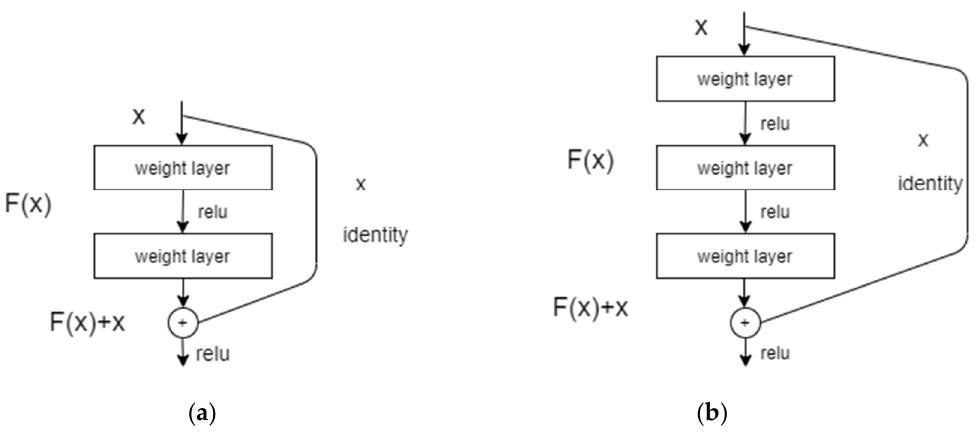
Figure 3. Two-level ResNet residual unit ( a ), Three-level ResNet residual unit ( b ) .